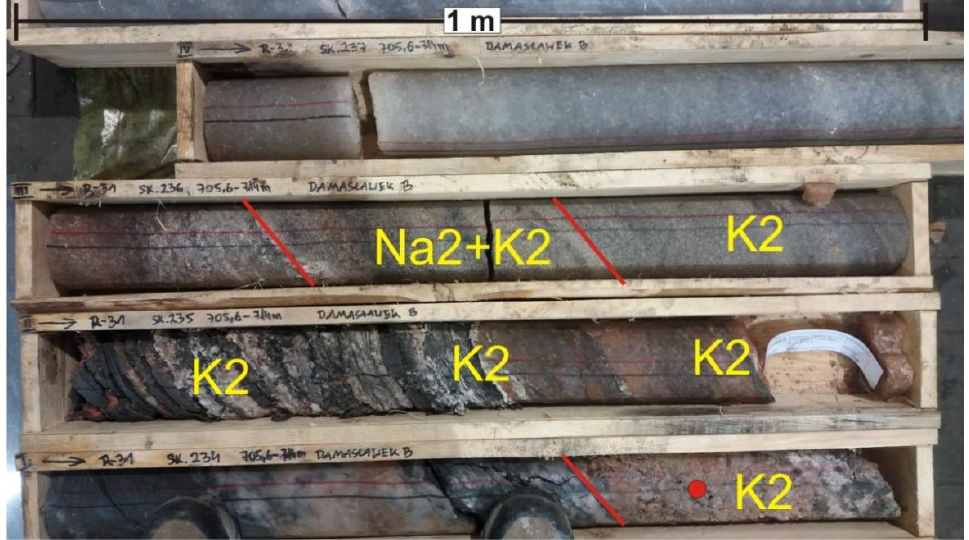
Figure 5. Core of Older Potash (K2) and Transitional beds Na2+K2 units in the profile of Damasławek B well, depth interval 705.6–709.6 m. Red point—sample.